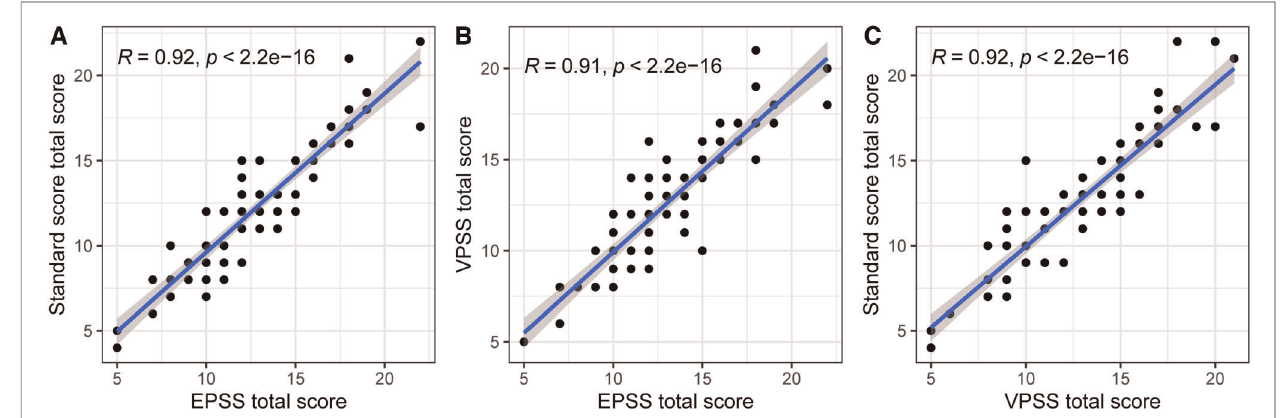
FIGURE 5 | Correlation between ( A ) EPSS total score and RS, ( B ) EPSS total score and VPSS total score, and ( C ) VPSS total score